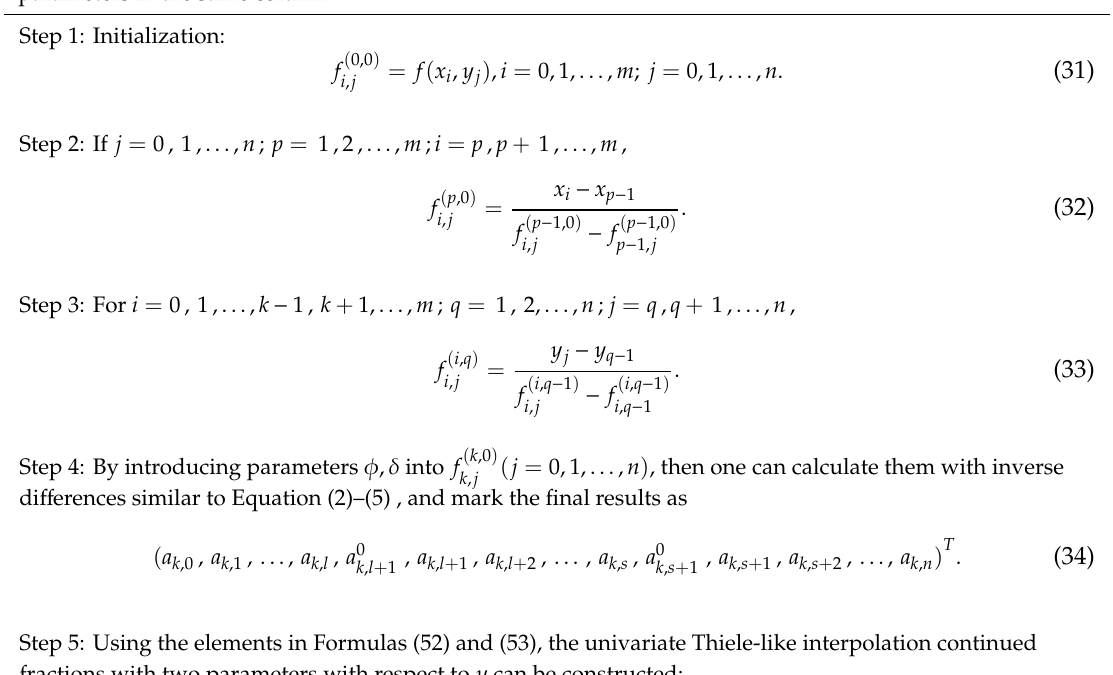
Algorithm 3 Algorithm of the Thiele-like branched rational interpolation continued fractions with two parameters in the same